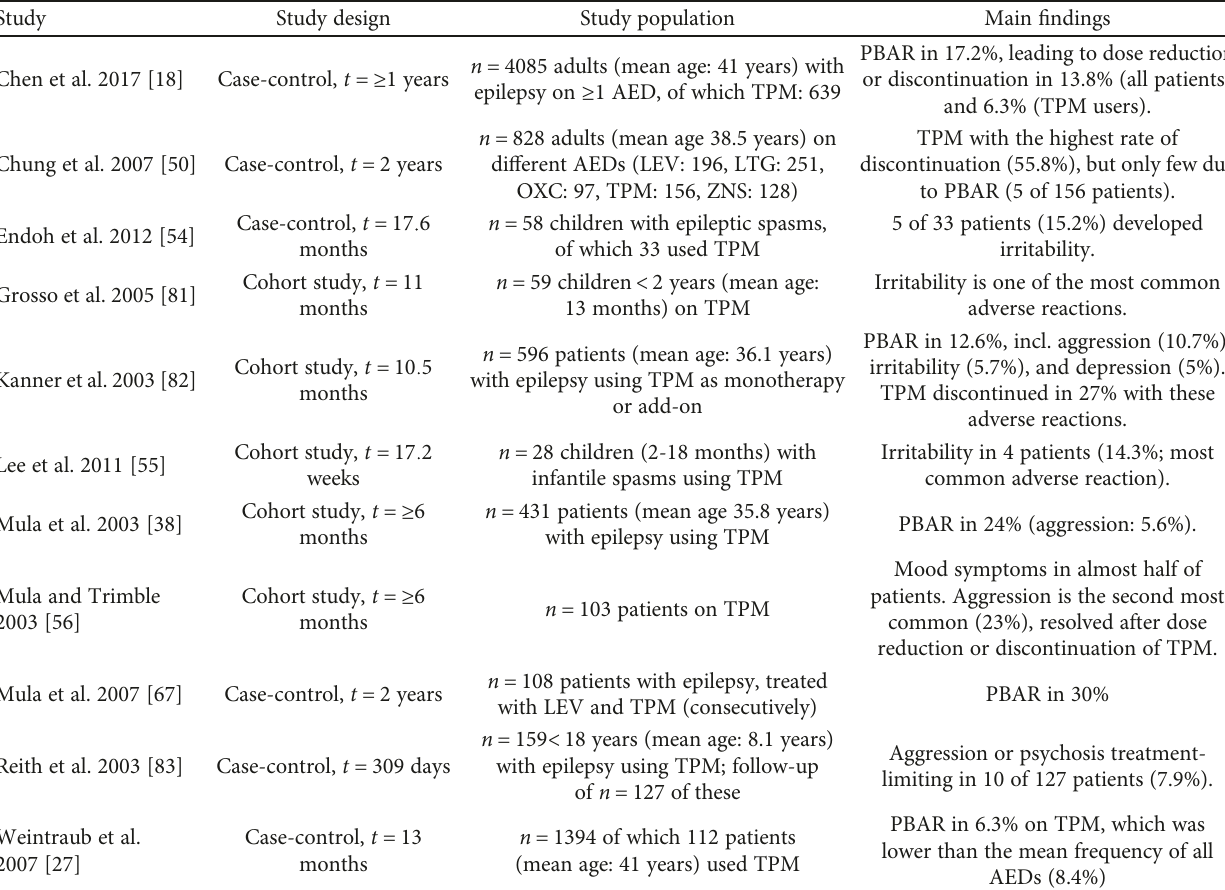
Table 4: Studies reporting psychiatric and behavioral adverse reactions to